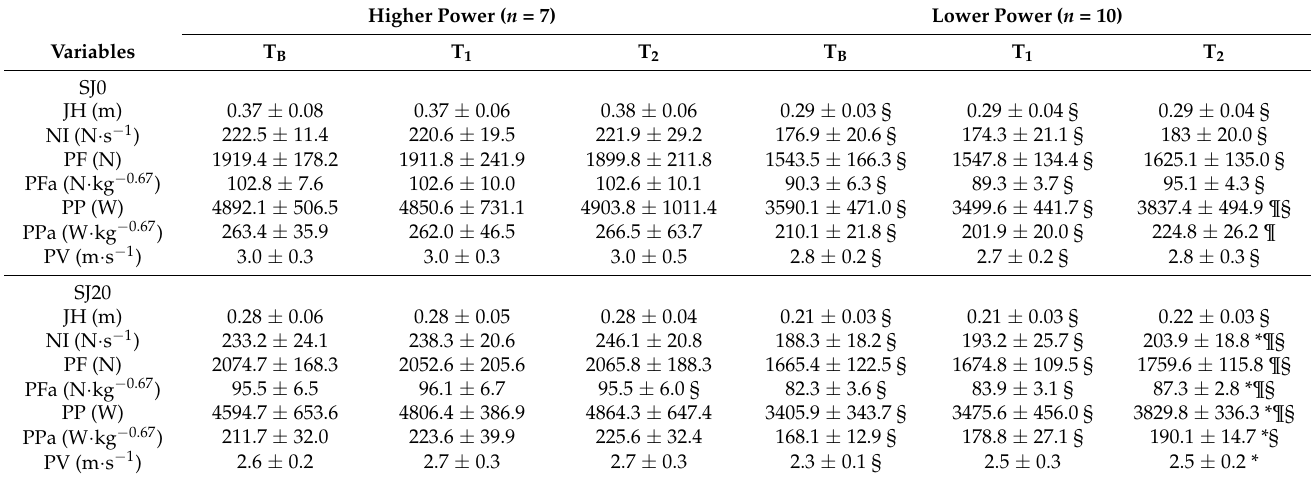
Figure 2. Effect size and 95% confidence intervals in squat jump and sprint changes in the higher and lower power groups. TB = Baseline. T1 = The start of the second training block. T2 = The end of the second training block. SJ0 = Squat jump with a polyvinyl chloride pipe. SJ20 = Squat jump with 20 kgs bar. SJ40 = Squat jump with bar loaded to 40 kgs. JH = Jump height. NI = Net impulse. PF = Peak force. Pfa = Allometrically-scaled peak force. PP = Peak power. PPa = Allometrically-scaled peak power. PV = Peak velocity. Table 5. Changes of selected squat jump and sprint variables in higher and lower power groups. Higher Power ( n = 7) Lower Power ( n =